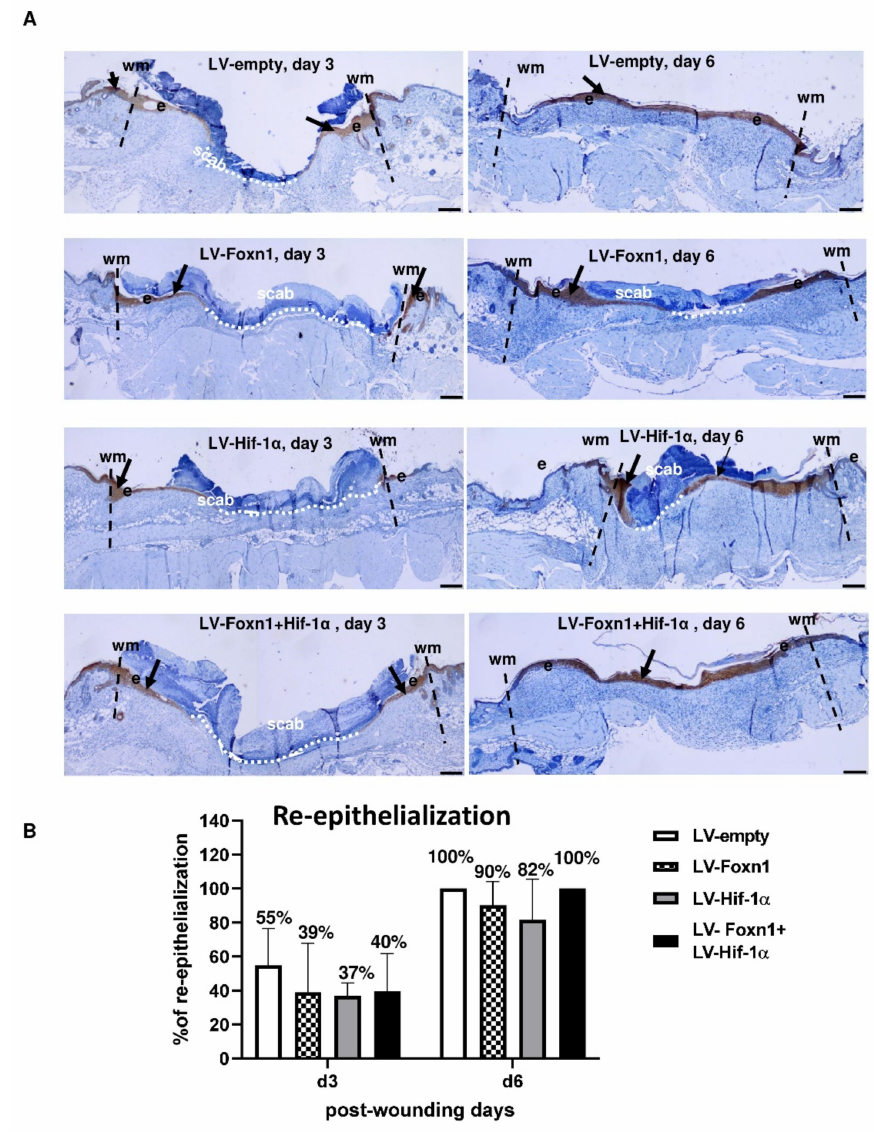
Figure 3. Microscopic evaluation of the re-epithelialization process in LV-empty-, LV-Hif-1 α , LV- Foxn1- or LV-Hif-1 α +LV-Foxn1-injected mice. ( A ) Representative histological sections of wounded skin stained for keratin 16 positivity (arrows); wm-wound margin, e-epidermis, scale bar 200 µ m. ( B ) Morphometrical analysis of the re-epithelization